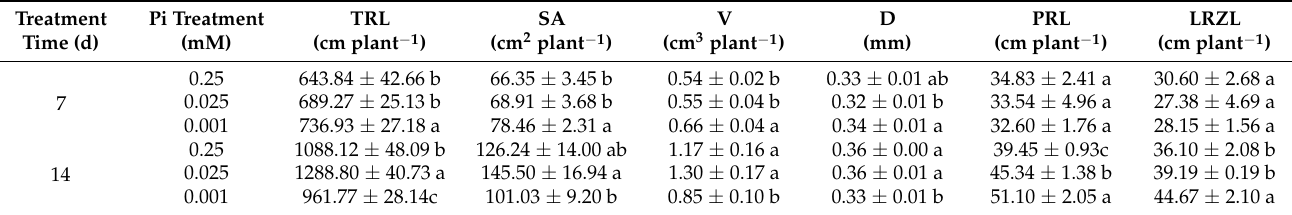
Table 3. Total root length (TRL), root surface area (SA), root volume (V), root average diameter (D), primary root length (PRL), and lateral root zone length (LRZL) of melon seedlings. The values are presented as the mean ± SD ( n = 3, 3 subsamples of each replicate). The lowercase letters indicate the significant difference in the parameter, at the same treatment time, among the treatments using one-way ANOVA with Tukey’s test ( p <